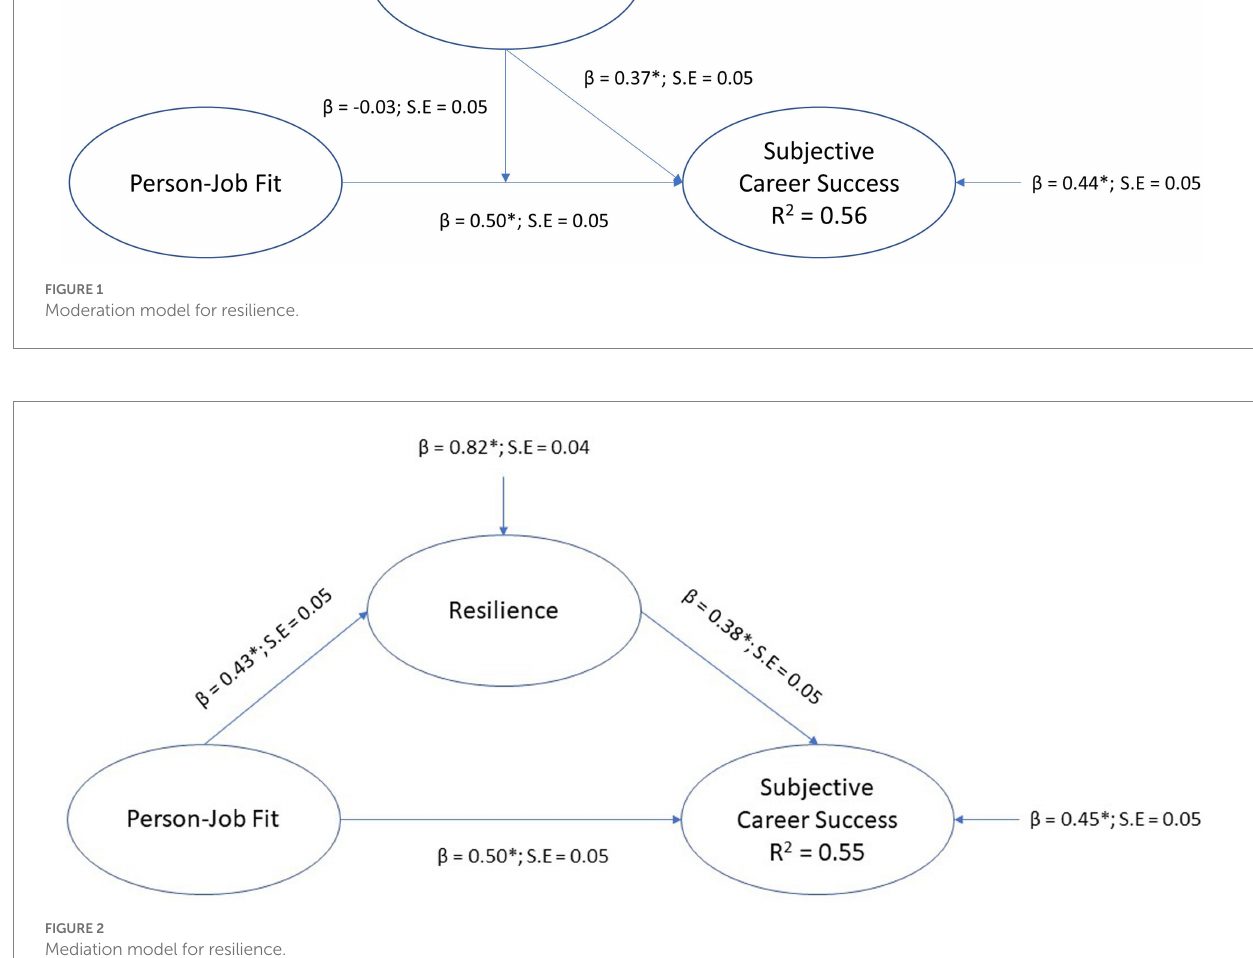
FIGURE 2 Mediation model for